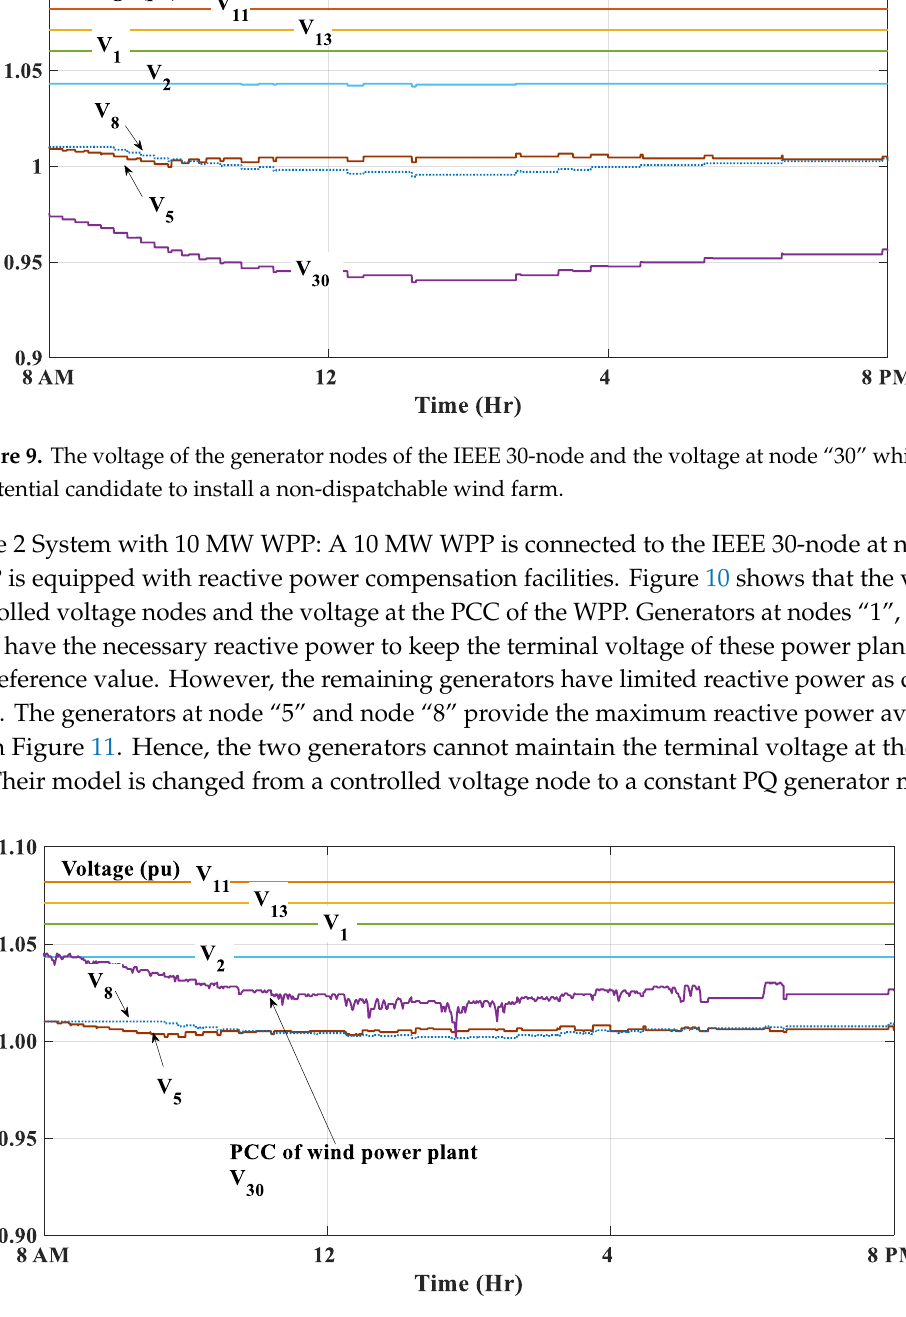
Figure 10. The voltage of the voltage-controlled nodes of the IEEE 30-node including a non-dispatchable 10 MW wind farm located at node “30”.